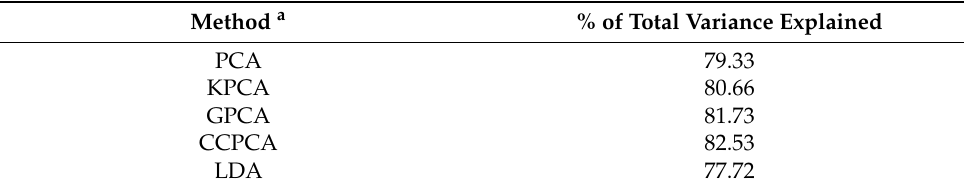
Table 3. Results of selection with the use of five methods: percentage of total variance explained for the four principal components.